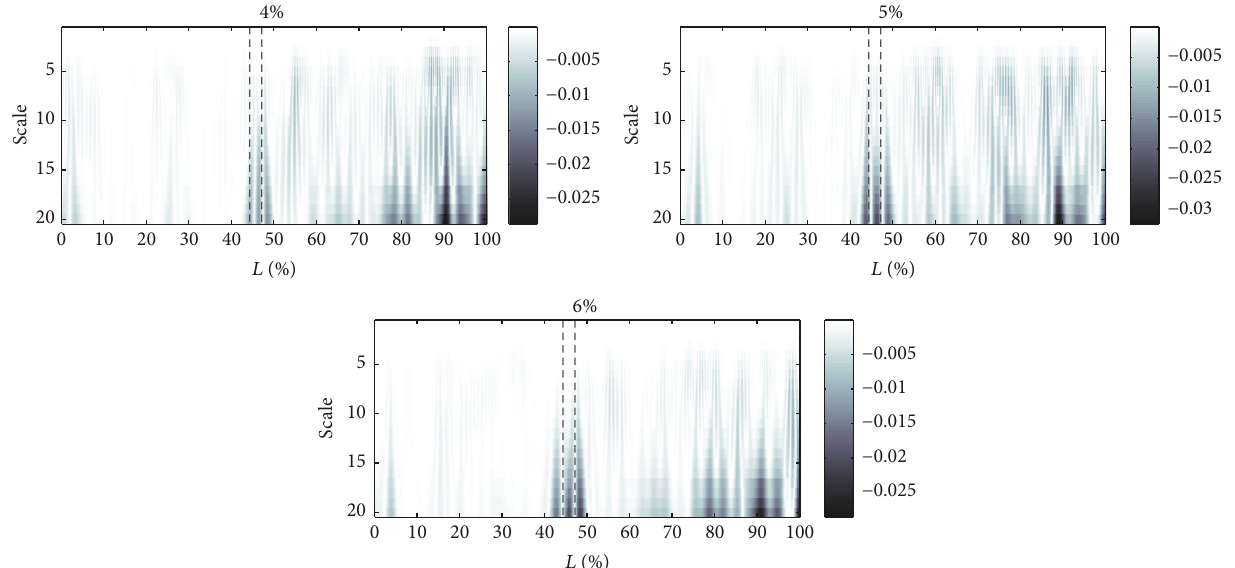
Figure 19: Scalograms of the 7th mode of natural vibrations obtained in the case of three different damage sizes.